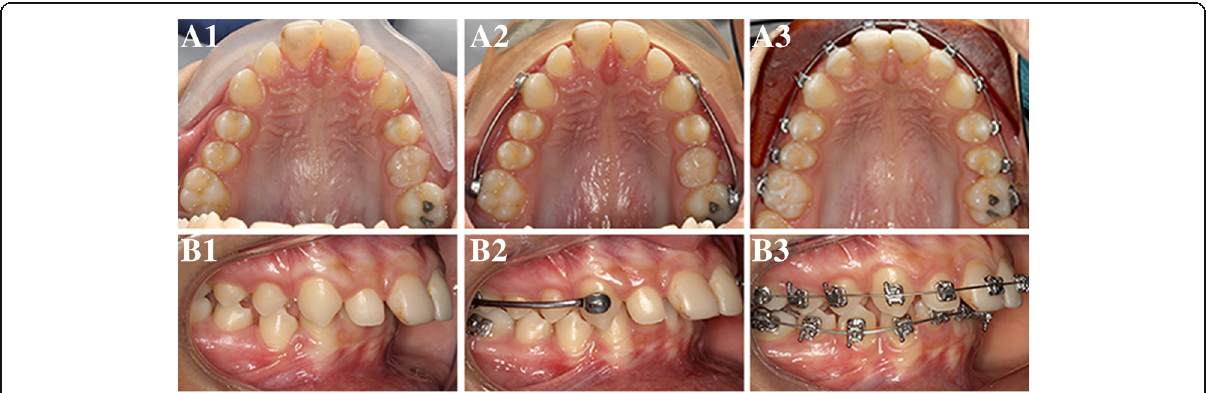
Fig. 9 Relapse of derotated molar with Carriere Distalizer . A1 and B1 pre-treatment intraoral photos. A2 and B2 progress photos after 3 months of treatment with Carriere Distalizer. A3 and B3 progress photos 1 month after removal of Carriere Distalizer. The right molar relationship was corrected to Class I with Carriere Distalizer (B2) and part of the correction was achieved by derotating the upper right first molar (A2). However, there was a relapse of derotated upper right first molar after Carriere Distalizer was removed